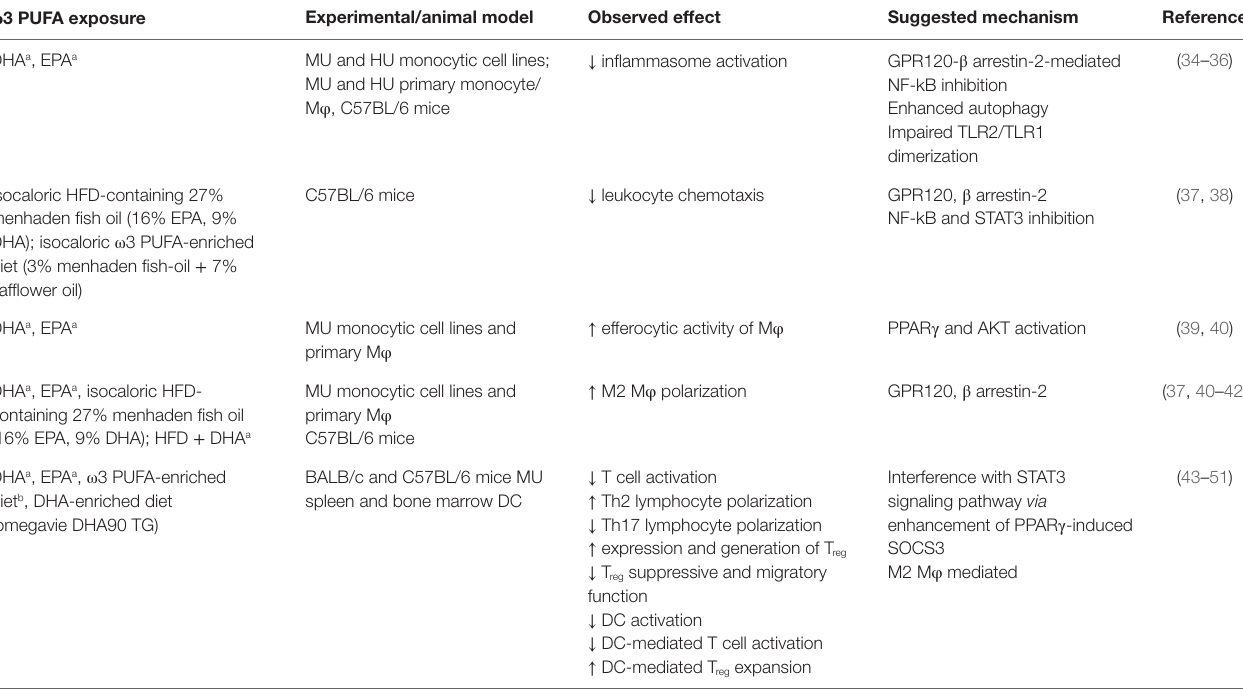
TAbLe 1 | immunomodulatory effects of ω 3 PUFA in monocyte/macrophages and T lymphocytes. ω 3 PUFA exposure experimental/animal model Observed